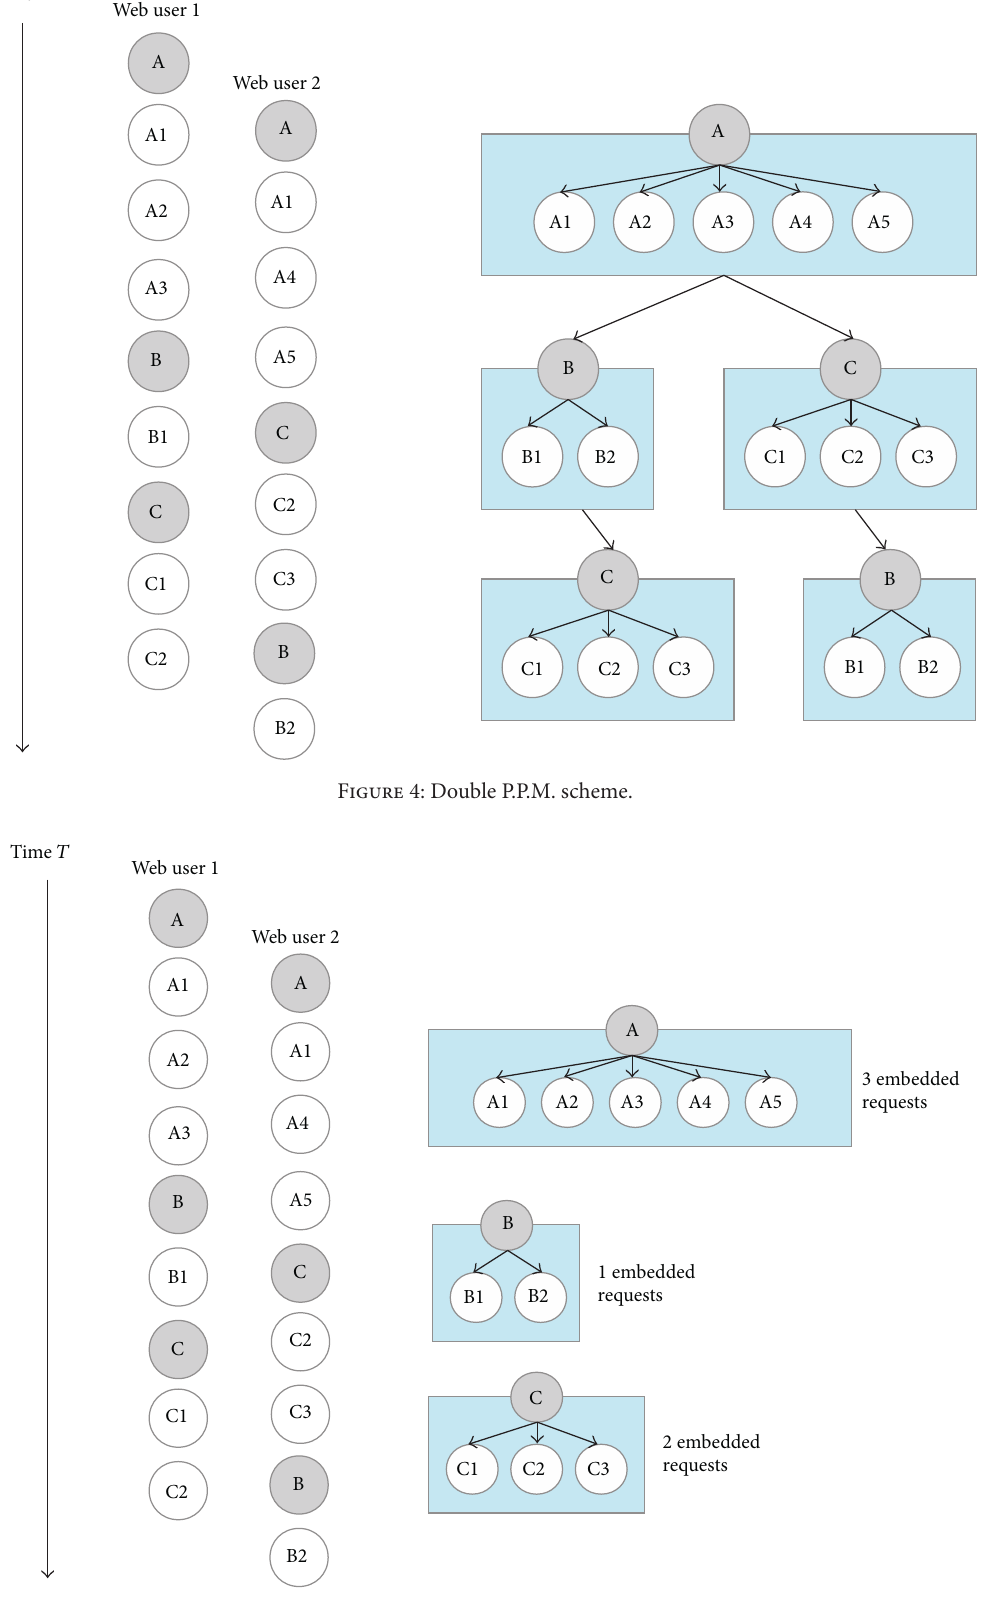
Figure 5: Classification of web objects depending on related embedded